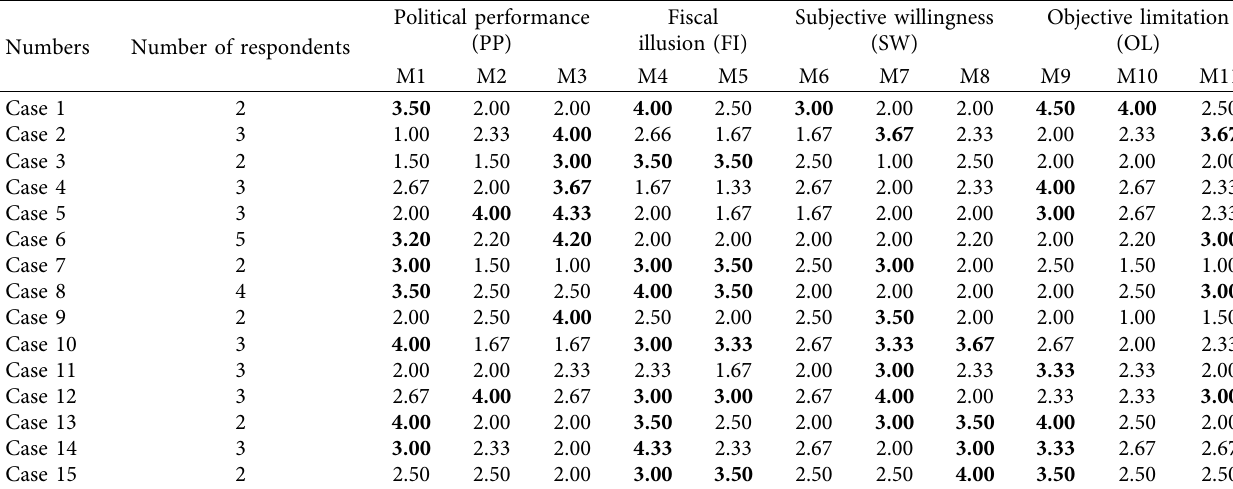
Table 5: Results of each case under each logic.